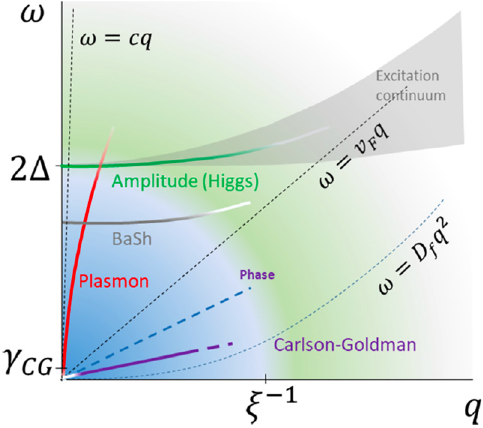
Figure 1: Schematic representation in the frequency – momentum plane of the collective modes that may appear in the electrodynamical response of a two-dimensional (2D) supercon- ductor. The blue area shows the low-energy and long-wavelength region, where weakly damped collective modes may be observed. Anticrossing between the plasmon and Higgs mode and the Bar- dasis – Schrieffer (BaSh) mode is not shown here. Here, c is the speed of light, v F is the Fermi velocity, and Df is the normal-state diffusion coef fi cient. Adapted from a study by Sun et al.